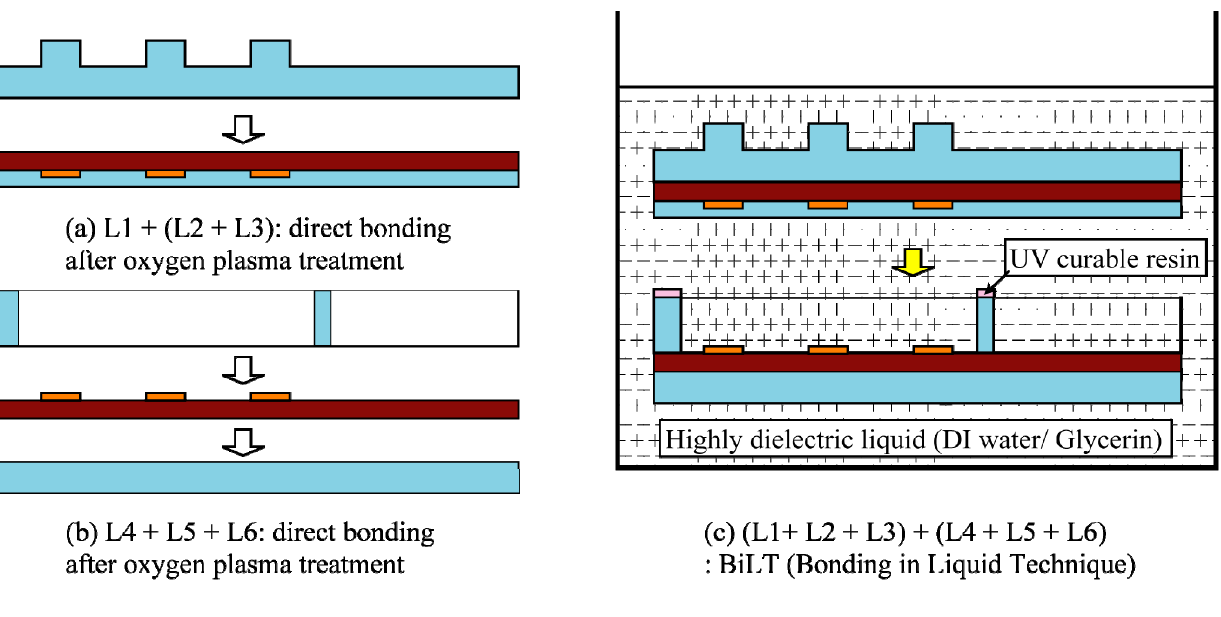
Figure 4. Assembling process of the proposed sensor. ( a , b ) bonding of PDMS layers to the polyimide films and ( c ) bonding of all layers while encapsulating highly dielectric liquid by using